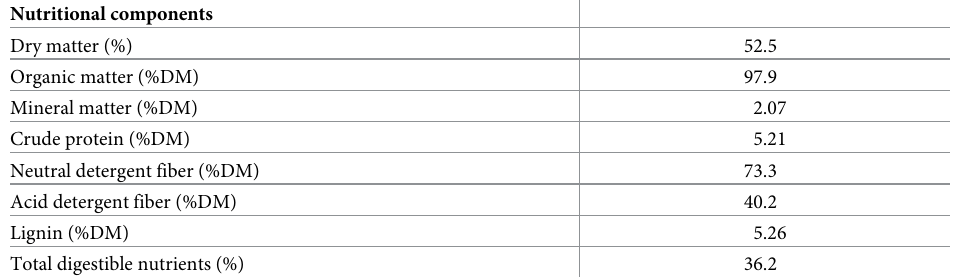
Table 1. Chemical composition of the leaf fraction of the pasture available for cows during the second trimester of gestation. Nutritional